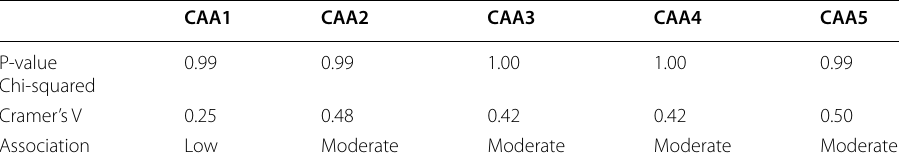
Table 7 Correlation analysis between course dropout and failure risk‑level identification